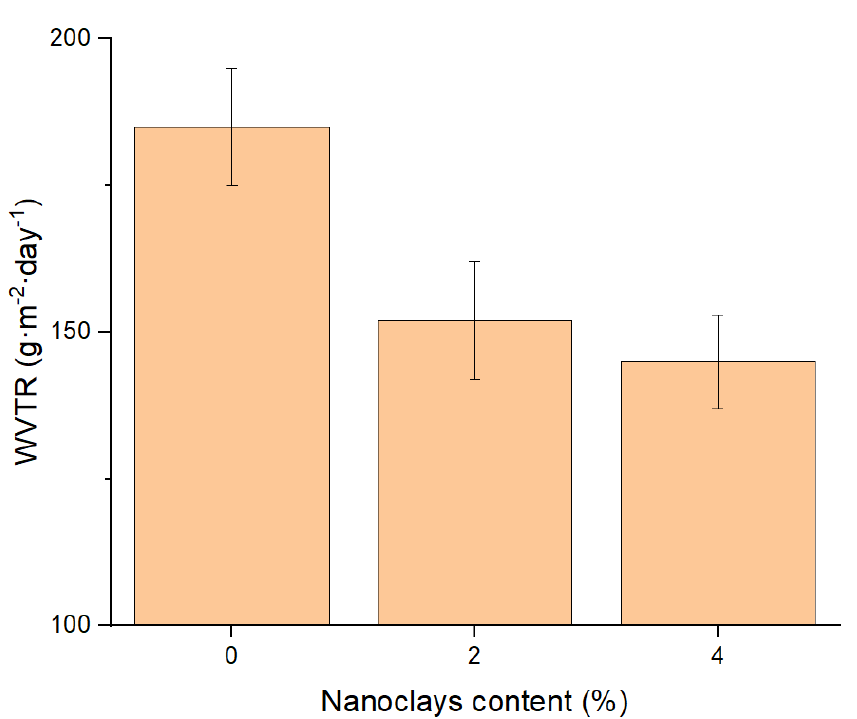
Figure 1. WVTR of PLA and its nanocomposites regarding the nanoclay contents and normalized to 25 μ m.